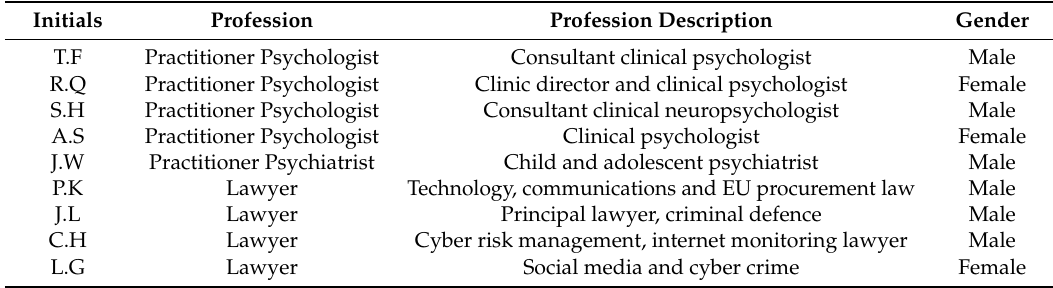
Table 1. Details of